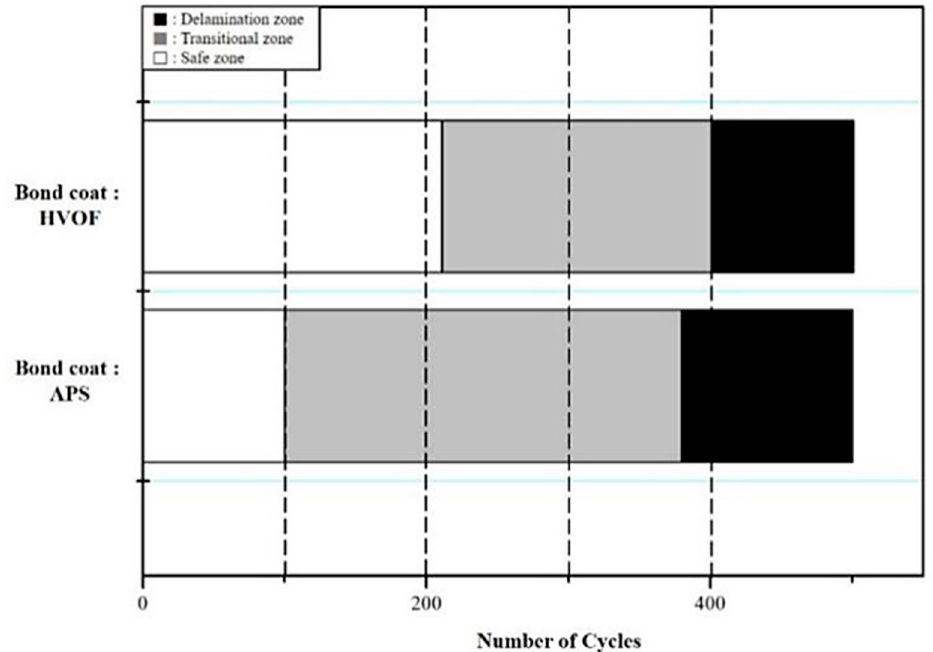
Figure 4. The service lives of TBCs with different bond coats after CFTF tests.